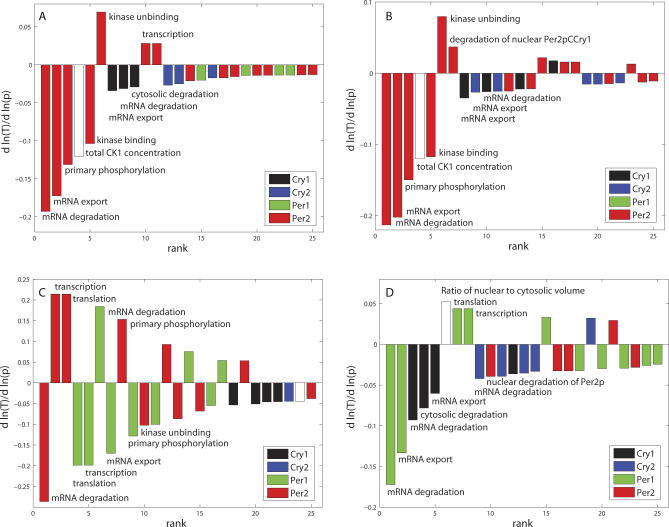
Top 25 Ranked Period Sensitivities for Different Numerical Experiments—Flipped Rate ParametersFlipped rate parameters between Per1and Per2 for (A) secondary phosphorylation rate, (B) transcription rate, (C) primary phosphorylation rate, and (D) mRNA degradation rate. Black, Cry1-related parameter; blue, Cry2-related parameter; green, Per1-related parameter; red, Per2-related parameter. Where Cry and Per related parameters overlap, the Per species colors are shown.